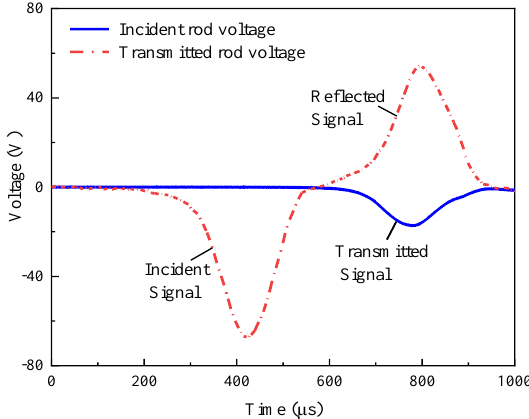
Figure 4. A classical wave of an SHPB test of coal.